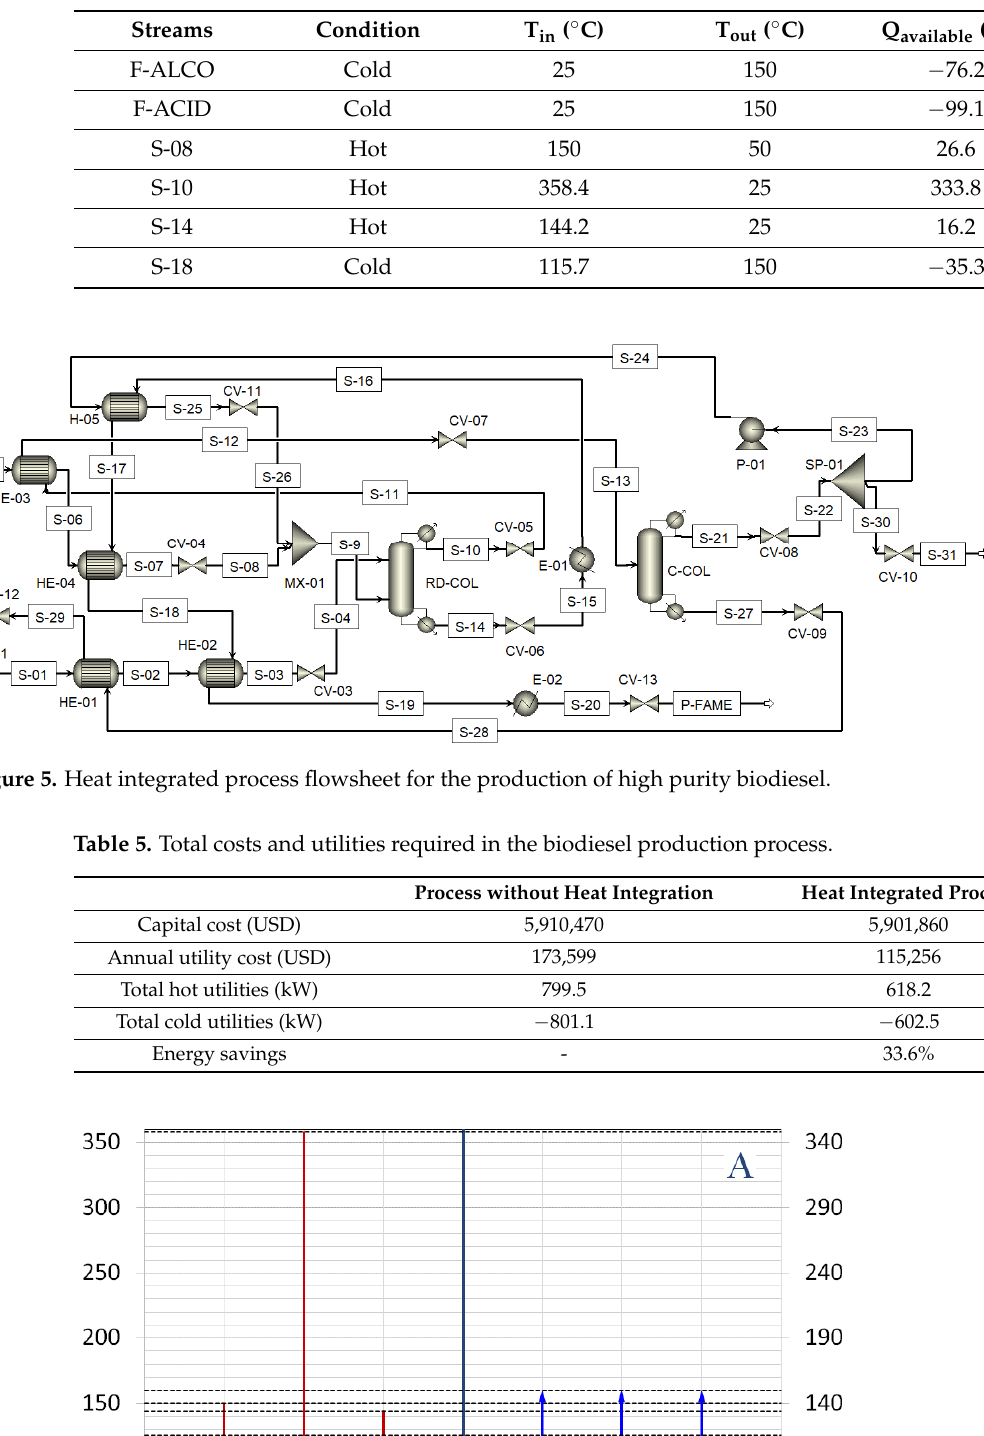
Figure 6. Temperature interval diagram.